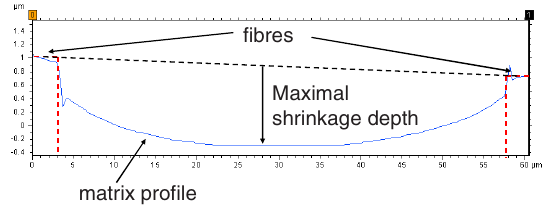
Fig. 2. Matrix profile between two fibres extracted by CIM.